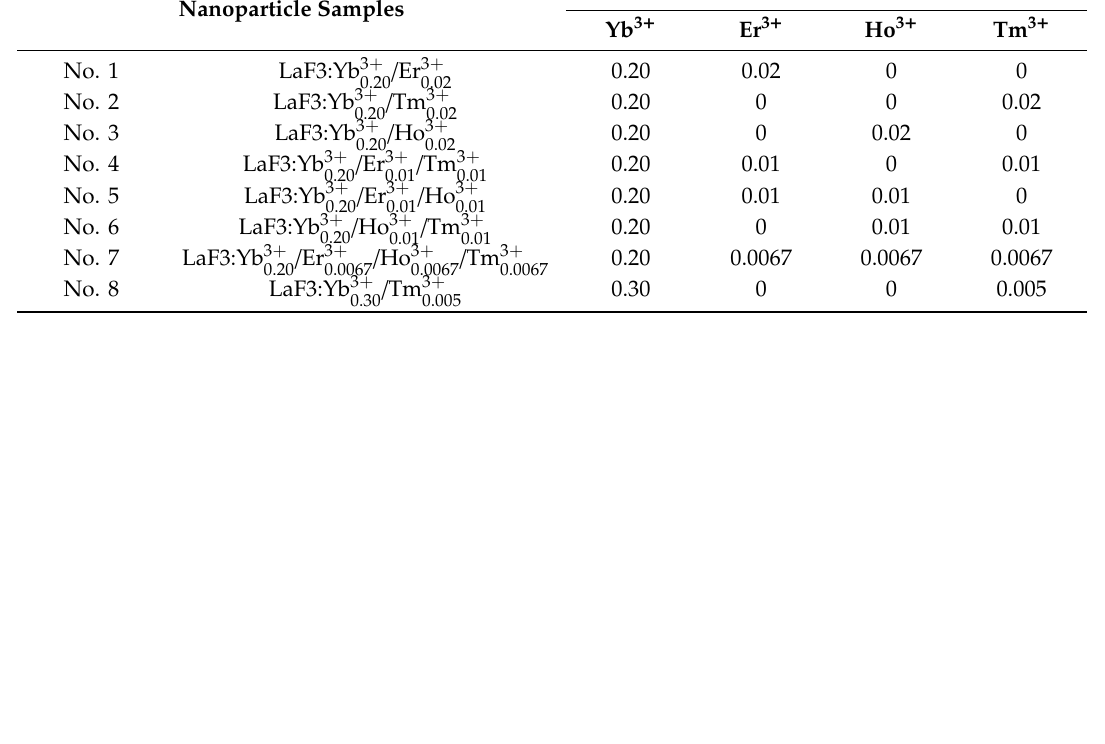
Table 1. The concentration of doping ions in LaF 3 :Yb 3 + / Er 3 + / Ho 3 + / Tm 3 + upconversion nanoparticles. Nanoparticle